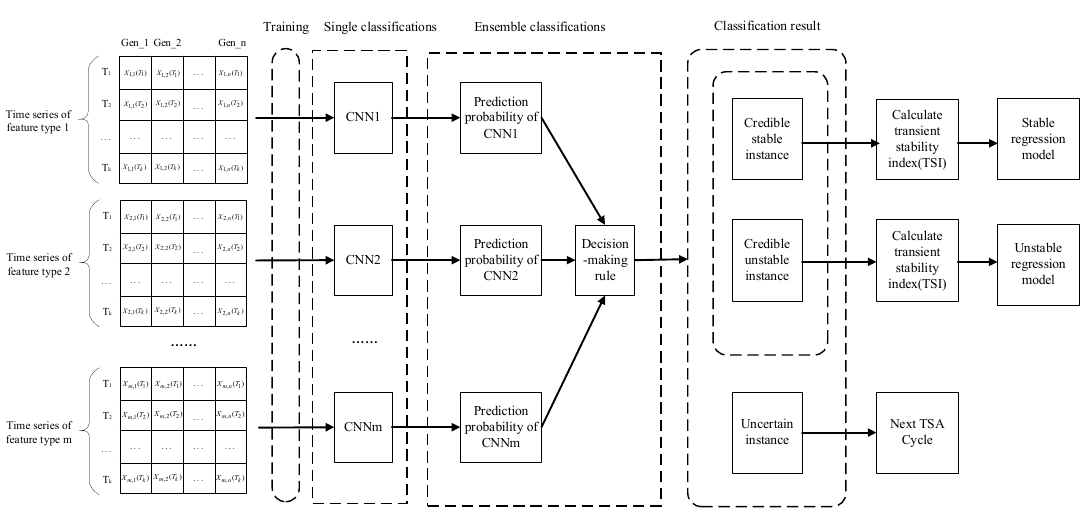
Figure 3. The workflow chart of the proposed intelligent system (IS) model.